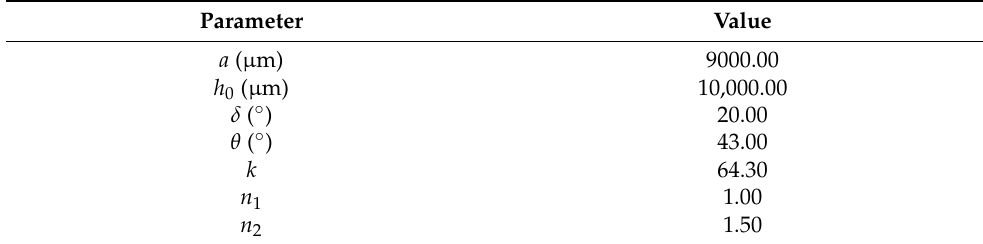
Table 3. The setting of